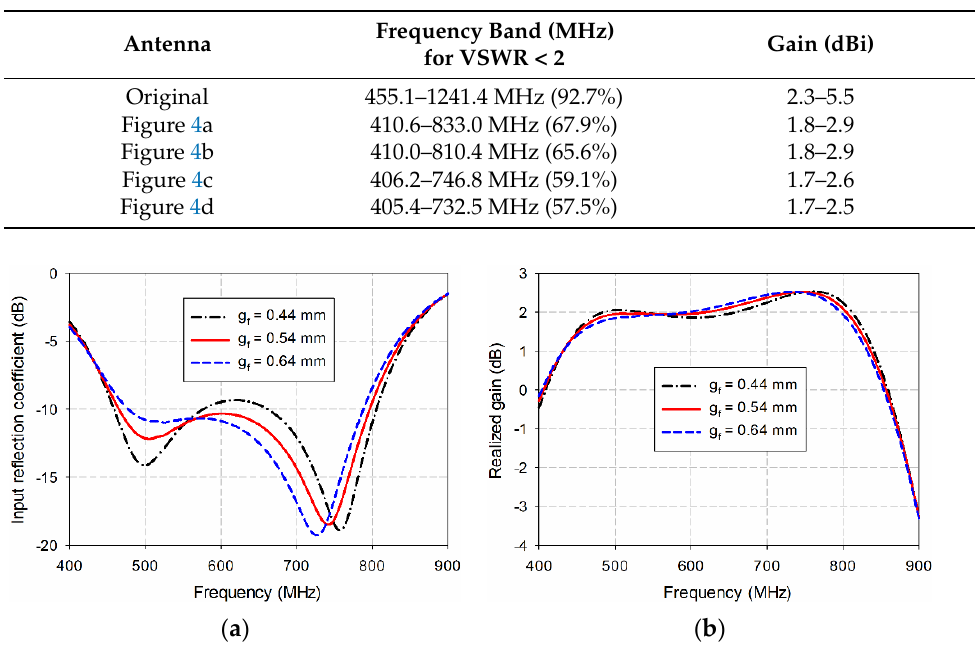
Figure 6. Effects of varying g f on the performance of the proposed antenna: ( a ) the input reflection coefficients; ( b ) the realized gain.